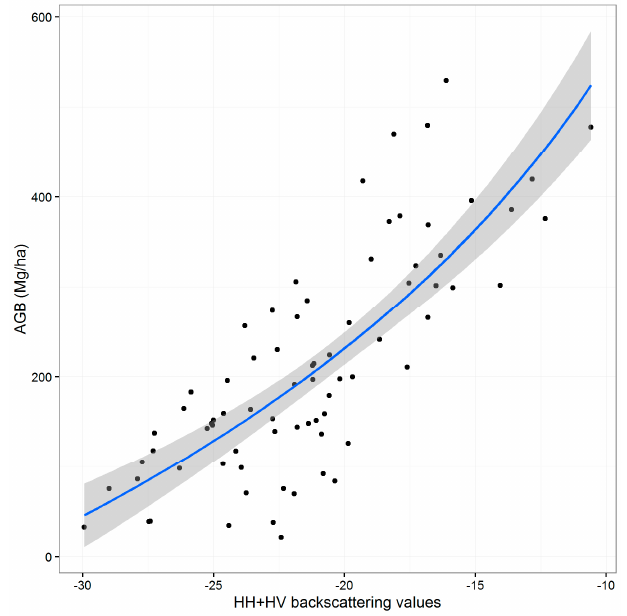
Figure 4. Scatterplot of AGB and HH + HV backscattering values. Remote Sens. 2017 , 9 , 18